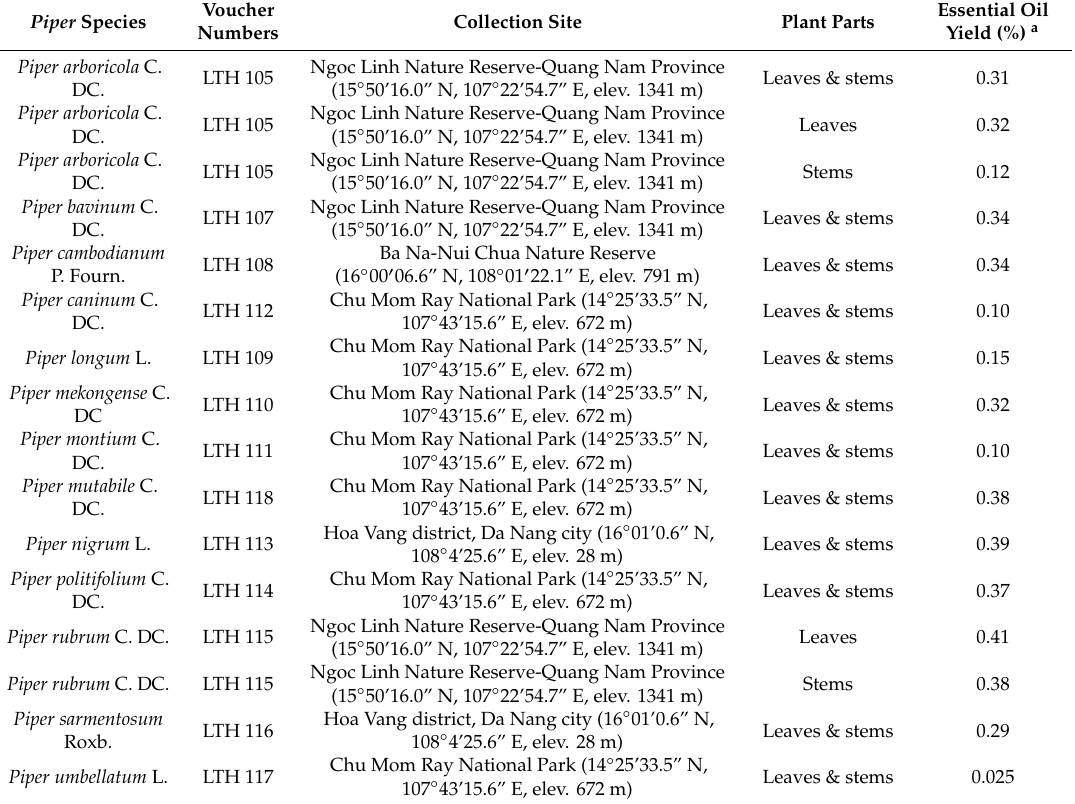
Table 1. Collection sites and essential oil yields for Piper essential oils from central